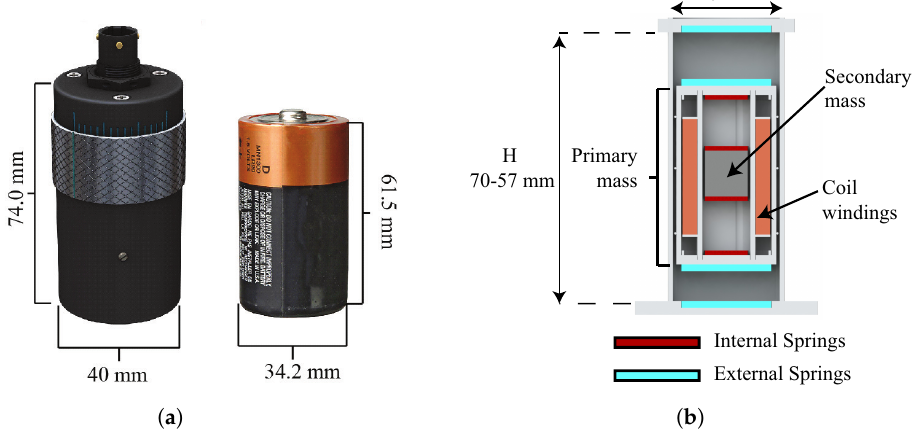
Figure 2. Stokes Power’s VEH-1: ( a ) illustration of the scale of the harvester with reference to a D-battery; ( b ) Schematic of the